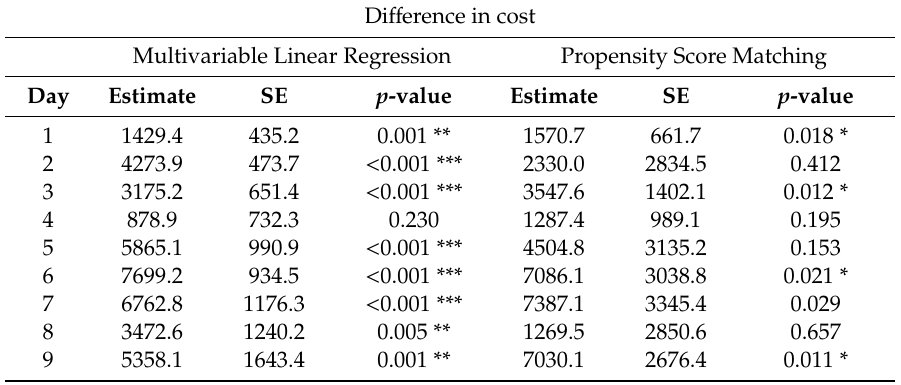
Table 6. Di ff erences in cost and length of stay for medication events (reference: without event). Di ff erence in cost Multivariable Linear